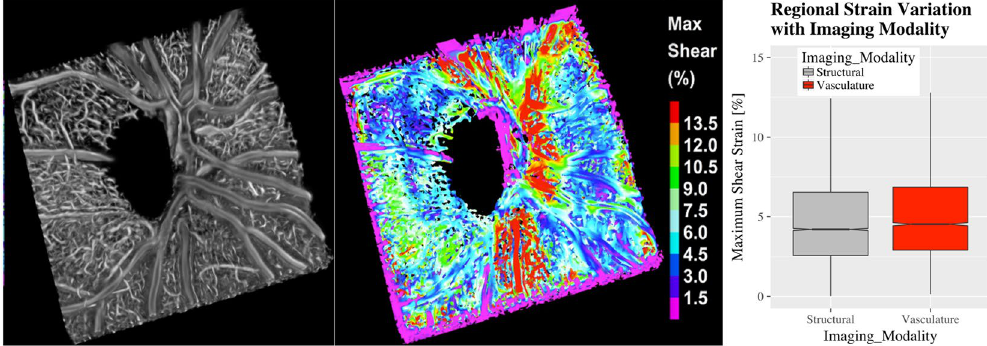
Figure 6. ( l ) Colocalization of SDOCT vasculature with Strain: (left) 3D map of the vasculature in the peripapillary retina (ppRetina) with co-localized to the strain (right) experienced by these tissues with an IOP change from 10 to 30 mmHg. ( r ) Distribution of strain in the ppRetina as it varied with imaging modality showing that strain localized in the vasculature was higher than in the structural tissue (0.90%, p =